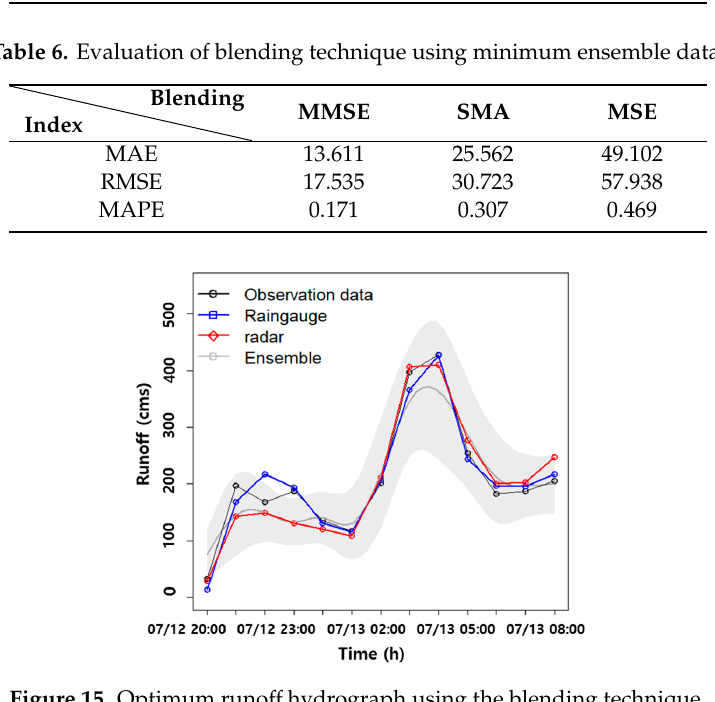
Figure 15. Optimum runo ff hydrograph using the blending